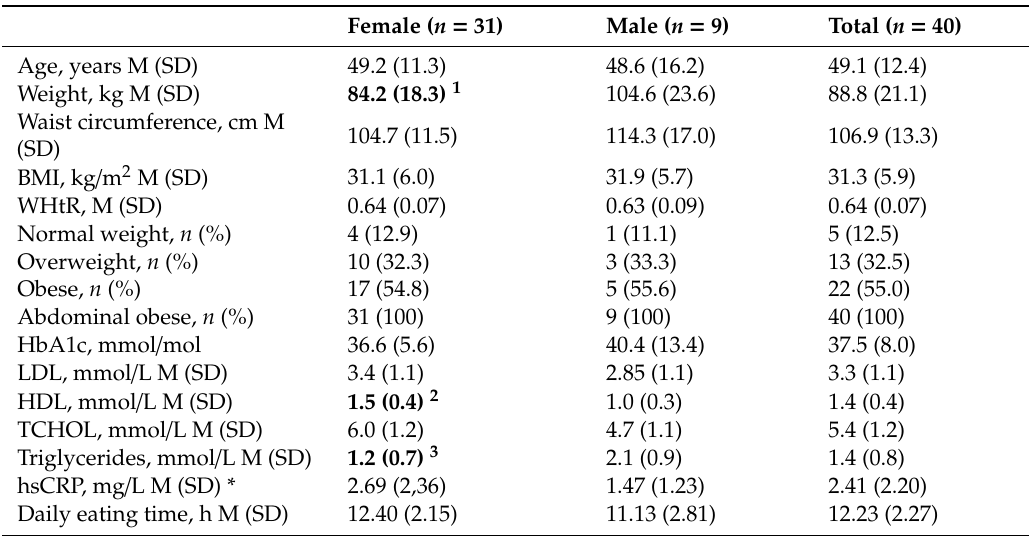
Table 1. Baseline characteristics of participants in the TRF-GP pilot study 2019.